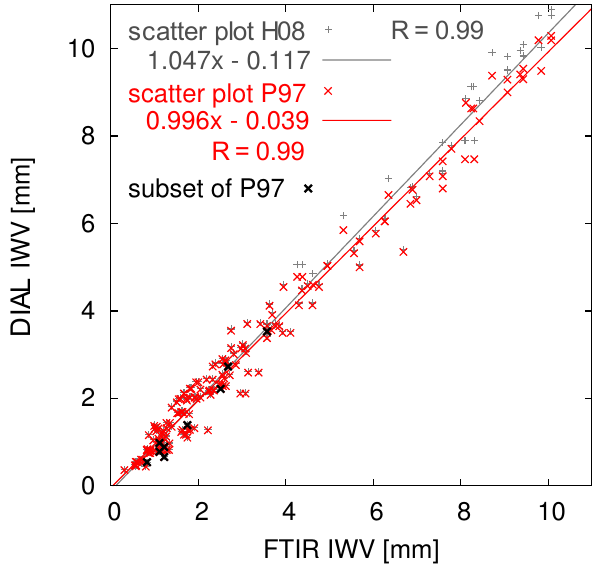
Fig. 2. Scatter plot of FTIR and DIAL measurements for different spectroscopic line parameters used for the water-vapor retrieval of the DIAL. “H08” (grey) is the result if HITRAN 2008 data (Roth- man et al., 2009) is used, “P97” (red) is the result if done so with the line parameters from Ponsardin and Browell (1997). For both H08 and P97 pairs of all day times within a coincidence interval of 22min have been considered. The grey and red lines are correla- tion lines for “H08” and “P97”, respectively. The nodes highlighted with a black cross show a subset of the P97 result which is reduced to pairs within a coincidence interval of 18min and an azimuth of 210 ◦ ± 6 ◦